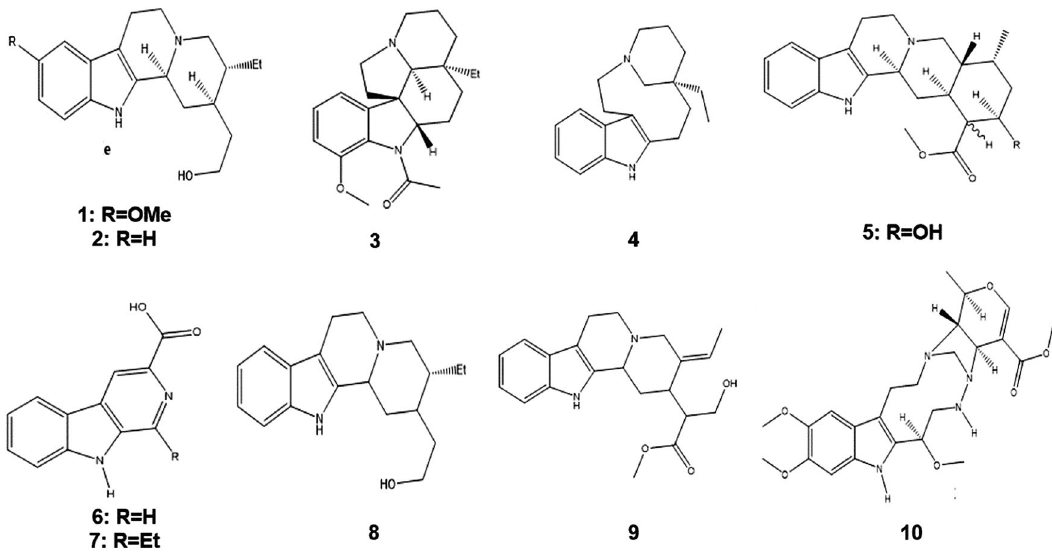
Figure 1. Chemical structure of compounds occurring in Aspidosperma nitidum. 10-methoxydihydrocorynantheol (1), corynantheol (2), aspidospermine (3), quebrachamine (4), yohimbine (5), carboxylic harman acid (6), 3-carboxylic ethylharman (7), dihydrocorynantheol (8), dehydrositsiriquine (9), braznitidumine